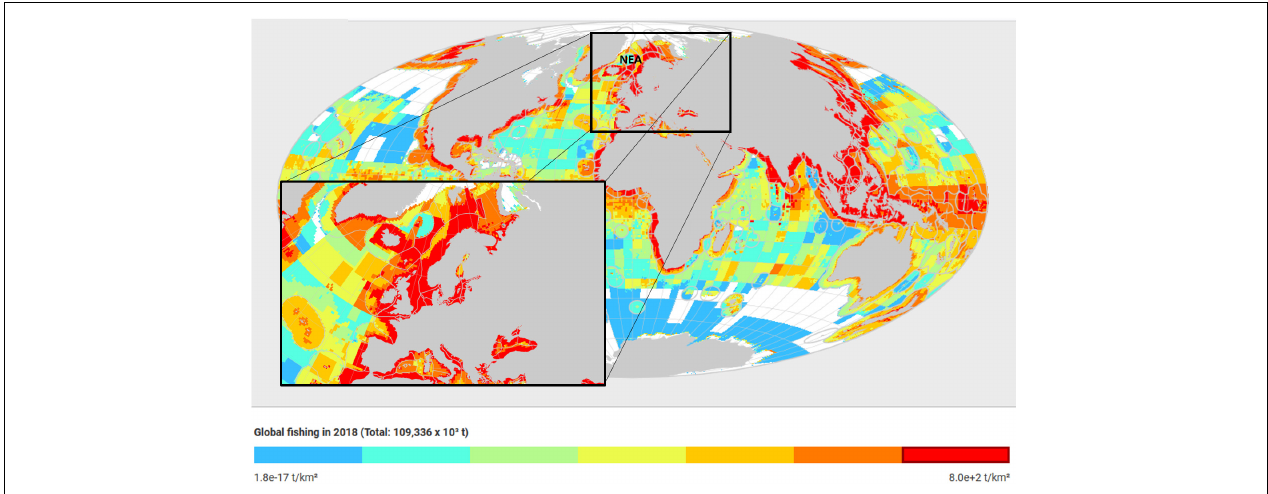
FIGURE 1 | European shelfregion (black rectangle) has one of the highest global fishing and catch areas and carbon sink intensity, especially the Northeast Atlantic (NEA). The NEA area is one of the highest-ranking areas, for both carbon sink and fishing intensity and responsible for about 14 and 15% of global carbon sink and global fishing effort, respectively (see Cavan and Hill, 2020). Map retrieved and modified from the Sea Around Us database (https://www.seaaroundus.org/data/#/spatial-catch; Pauly et al.,